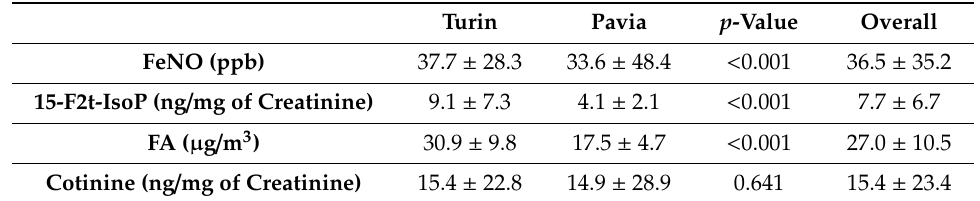
Table 2. General description of environmental and biological measurements presented as subgroups by city. The statistical di ff erences between the two cities are reported (M–W